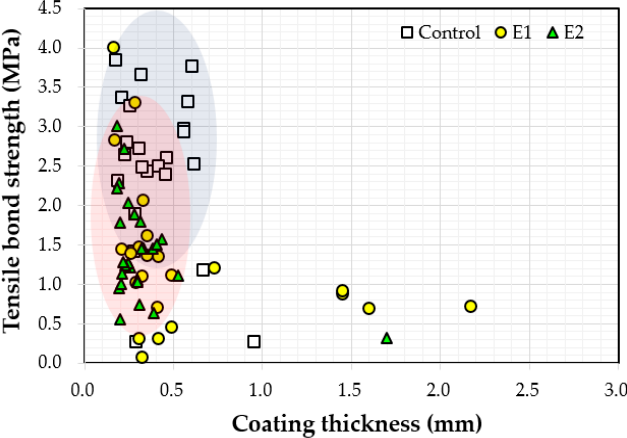
Figure 11. Correlation between the measured coating thickness and bond strength.